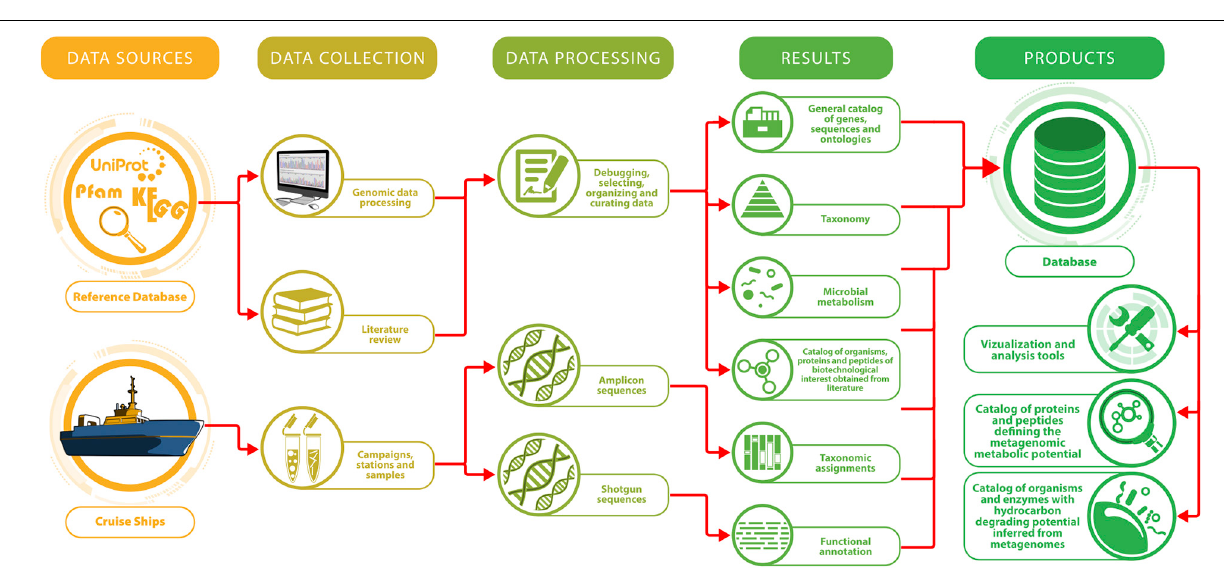
FIGURE 3 | Metagenomic information System of the Gulf of Mexico. Workflow showing the followed steps for data and sample collection, processing and